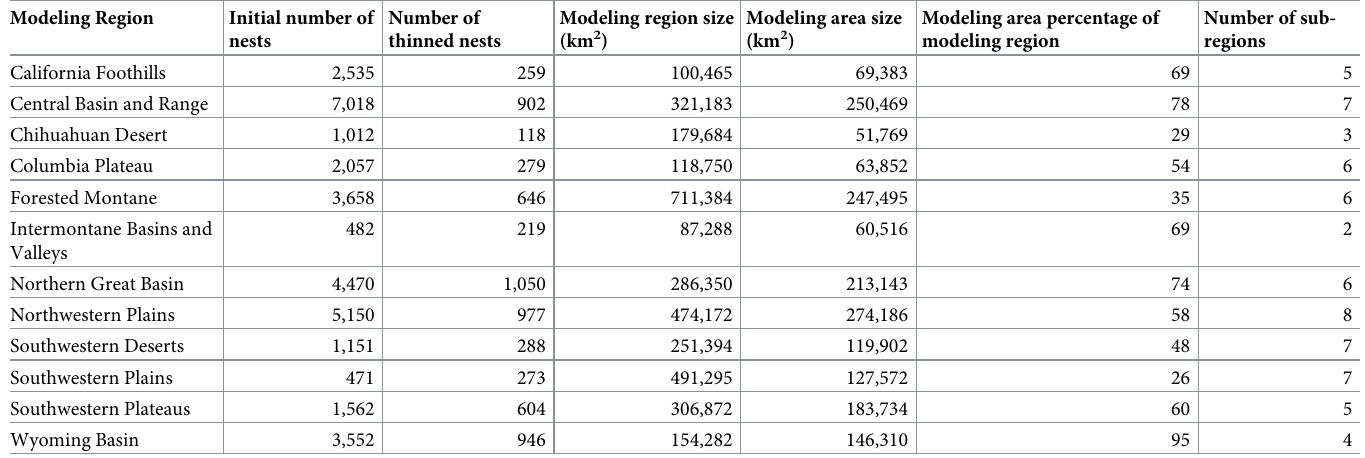
Table 1. Characteristics of sample size of golden eagle nest sites and modeling regions used for developing golden eagle nesting area models in the western U.S. Ini- tial number of nests is the full sample of nests we had available to us and that passed our quality control process. Number of thinned nest sites is the sample of nest sites used for model development, after we thinned the initial sample to reduce the chance of pseudoreplication. Modeling region size is total size of modeling region, whereas modeling area size is the union of 20-km radius circles around the thinned nest sites. Modeling area percentage of modeling region is the result of dividing the modeling area by modeling region sizes (x 100). Number of sub-regions is the number of discrete sub-regions within each modeling